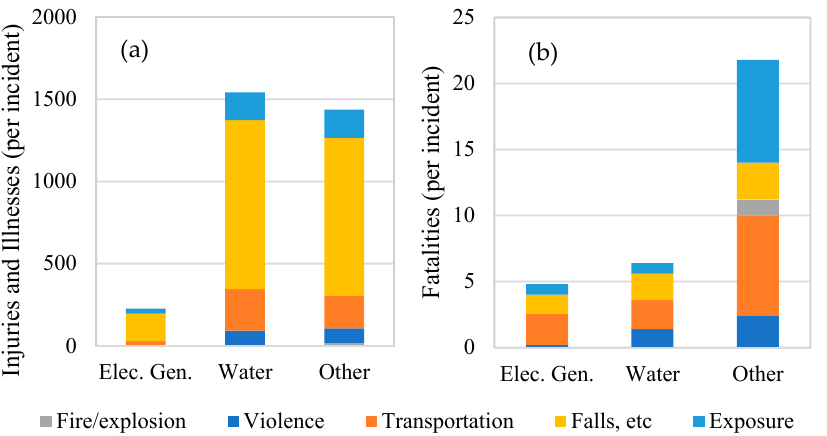
Figure 5. Average annual incidents of ( a ) injuries and illnesses and ( b ) fatalities per incident in subgroups Elec. Gen. (i.e., Electric power generation) (NAICS 22111) and Water (i.e., Water, sewage and other systems) (NAICS 22113). Other represents remaining illnesses, injuries and